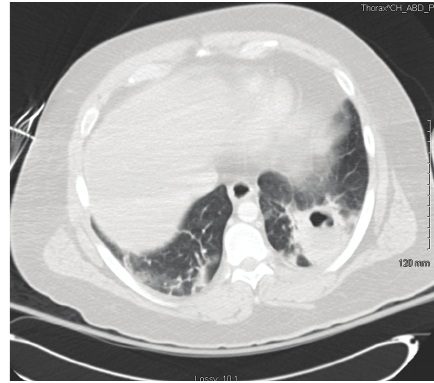
Figure 2: CT of the chest where left lower lobe cavitary lesion is